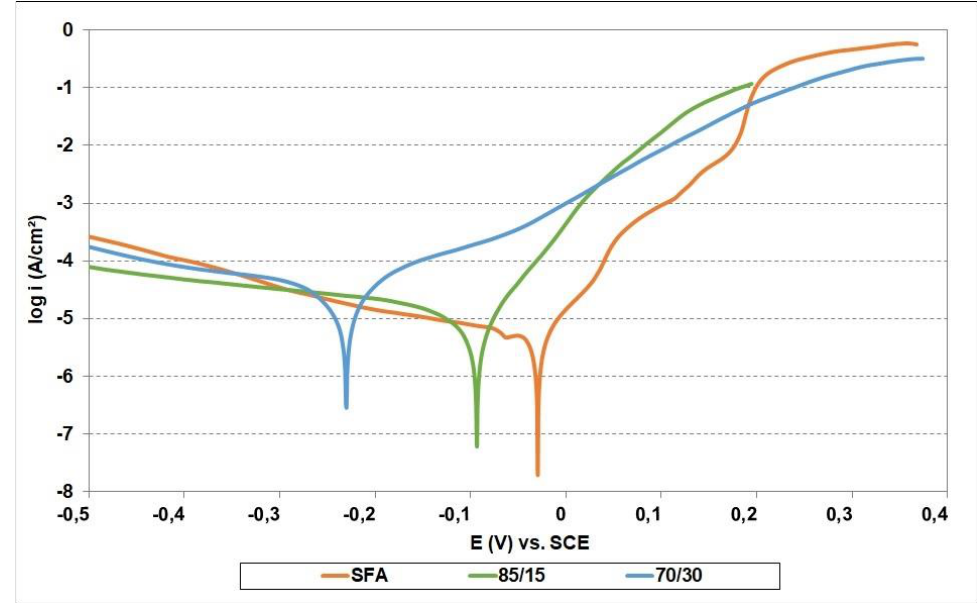
Figure 5. Potentiodynamic polarization curves of the coatings.